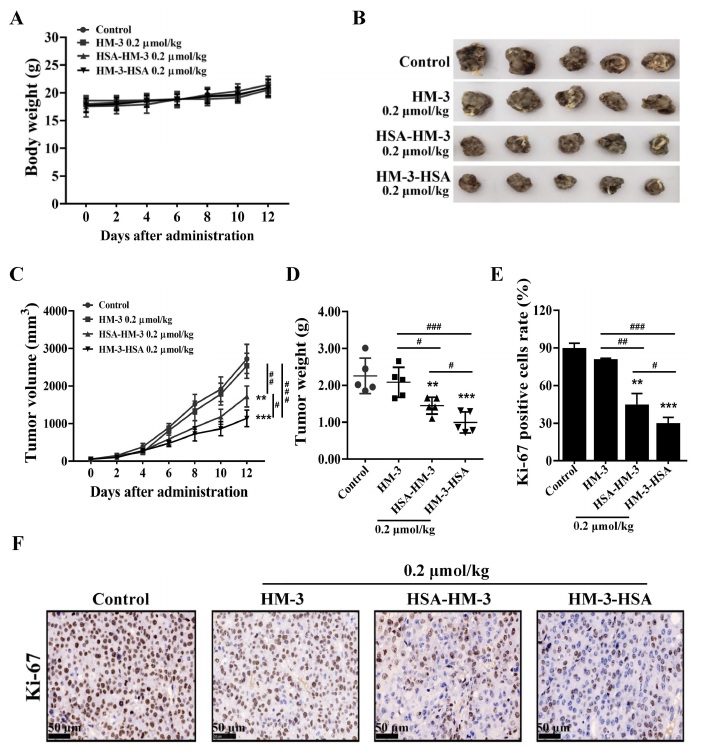
Figure 8. The effect of HM-3/HSA on the growth of the B16F10 tumor. ( A ) The body weight of mice. ( B ) Tumor picture. ( C ) HM-3/HSA inhibited the B16F10 tumor volume ( n = 6 mice/group). The volume was measured at 2 d, 4 d, 6 d, 8 d,10 d, and 12 d after administration. ( D ) HM-3/HSA inhibited the B16F10 tumor weight. Tumor weight in different treatment groups was measured at the end of treatment. ( E ) The Ki-67 expression level of B16F10 melanoma tissues was counted and presented in the histogram. ( F ) Ki-67 immunohistochemistry pictures of tumor tissues. Control: mice treated with the PBS vehicle only. Scale bar = 50 µ m. ** p < 0.01, and *** p < 0.001 vs. control; # p < 0.05, ## p < 0.01, and ### p <